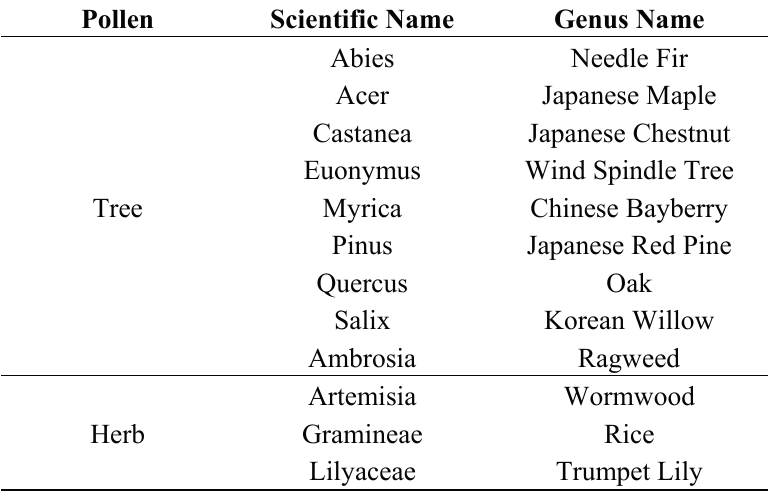
Table 3. Pollen counts. Total pollen counts were measured in three areas of Incheon